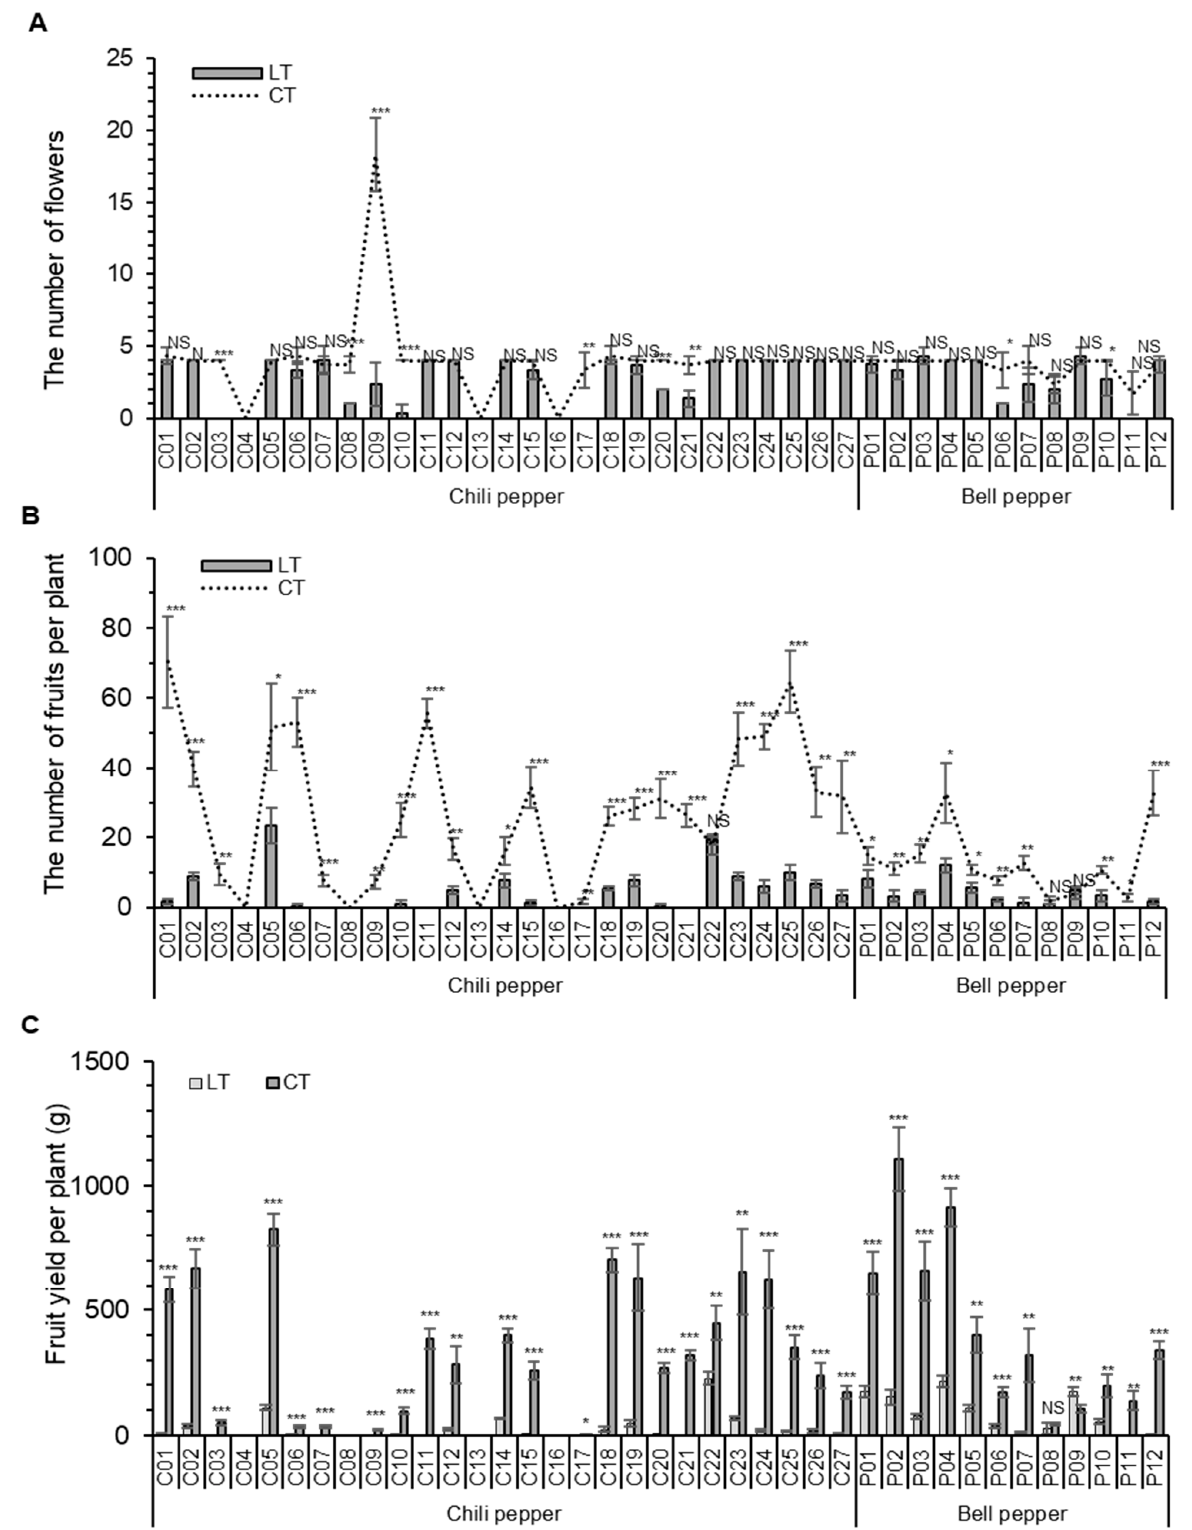
Figure 2. The evaluation of reproductive traits on ( A ) the number of flowers, ( B ) the number of fruits, and ( C ) fruit yield among 39 pepper accessions in LT and CT greenhouses. The reproductive parameters were measured at 120 days after transplanting. Significant differences were evaluated with Student’s t -test with p ≤ 0.05, p ≤ 0.01, and p ≤ 0.001 and denoted by *, **, and ***, respectively. NS means not significant and bars indicate ± standard deviation. ( n = 3).